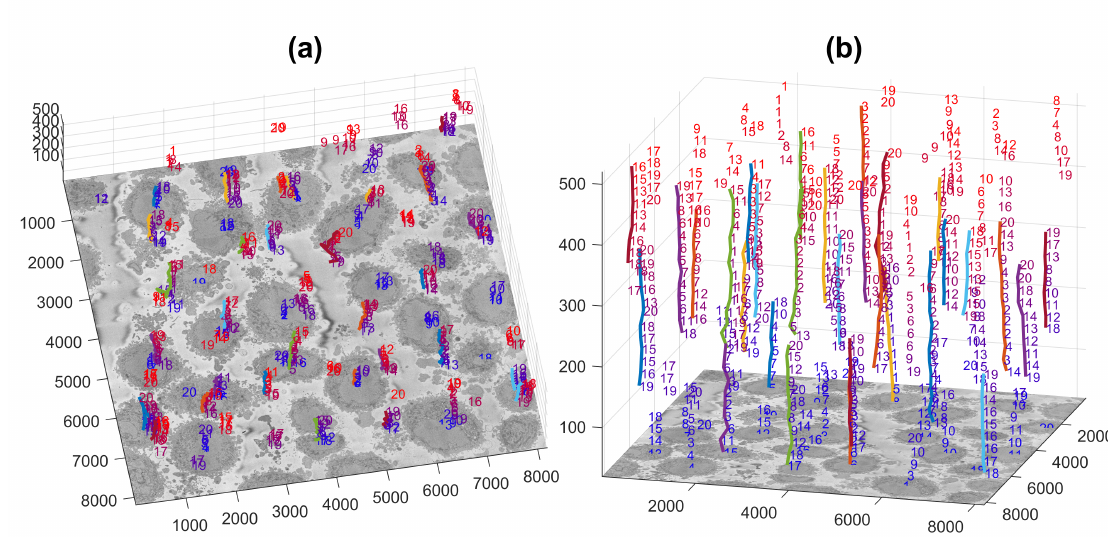
Figure 3. Centroids of cells that were identified per slice are displayed in three dimensions. Each number corresponds to the centroid of one cell that has been identified in a given slice. The numbers decrease according to the rank of the cell in that slice with 1 being the largest cell detected in that slice. The colour of the font varies from blue (lower slices) to red (higher slices) for visualisation purposes. A coloured line with a random colour is placed next to the centroids that were associated as a single cell. ( a , b ) show the same information from different points of view. The units of the axes are in